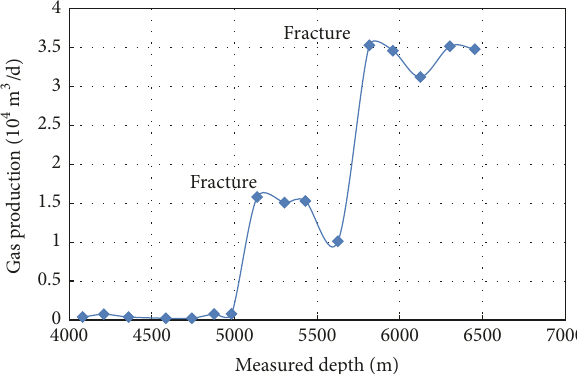
Figure 5: Gas production from a fractured reservoir while